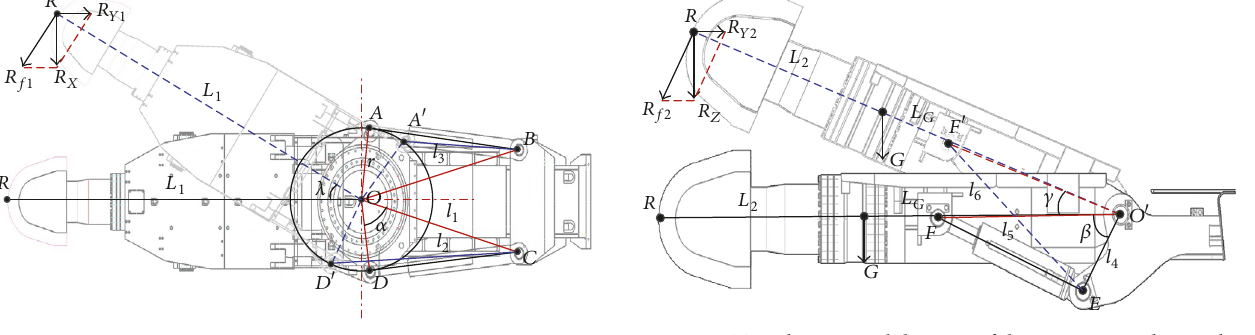
Figure 3: Two-dimensional diagram of the cutting arm during the horizontal swing process.